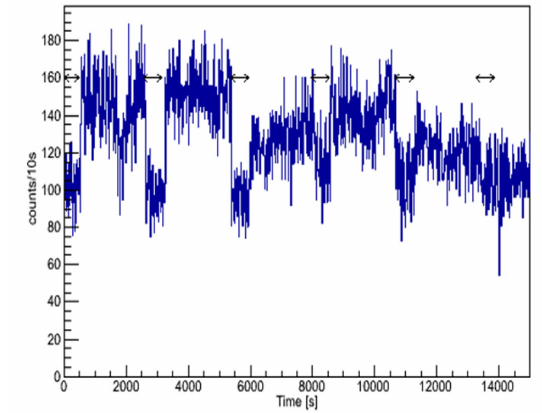
Fig. 4. Arrows indicate when the target is swiveling within region comprising Mylar-Sulfur and Mylar only areas. Target positions are selected when high Sulfur spots are found. The scaler plot is obtained for protons measured with energy E p between 2.45-2.65 MeV. The accumulated time is 4 hours at I b = 6 nA, E b = 3